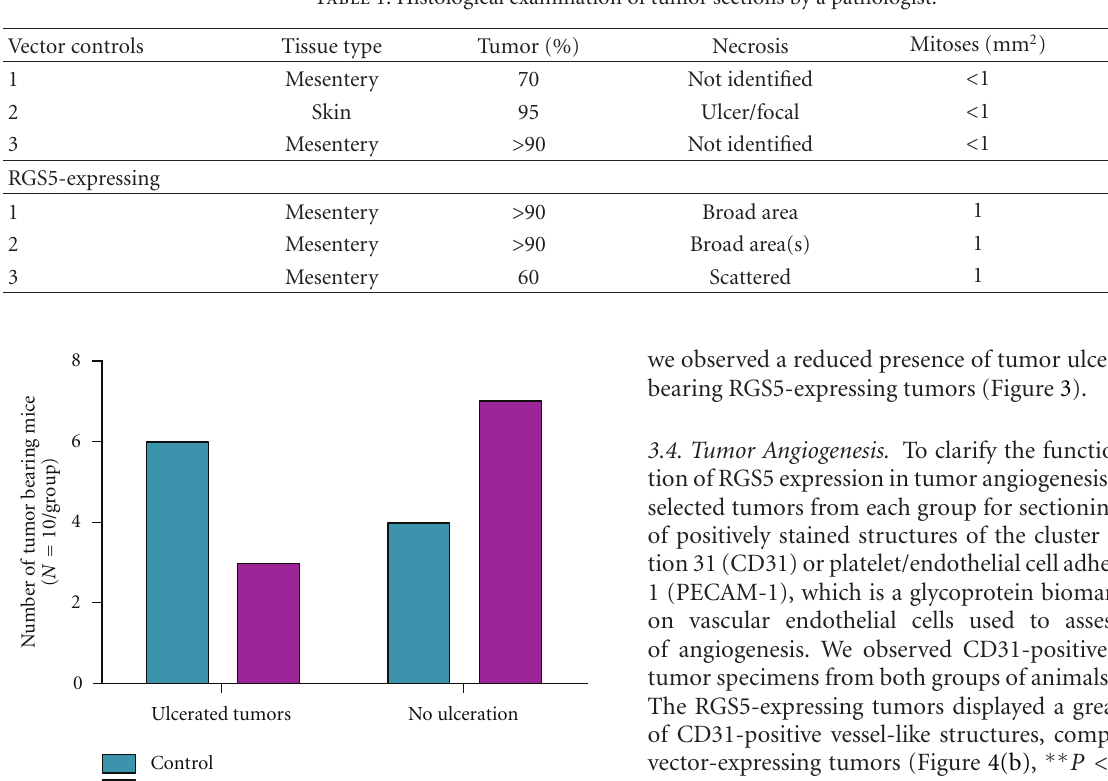
Table 1: Histological examination of tumor sections by a pathologist.